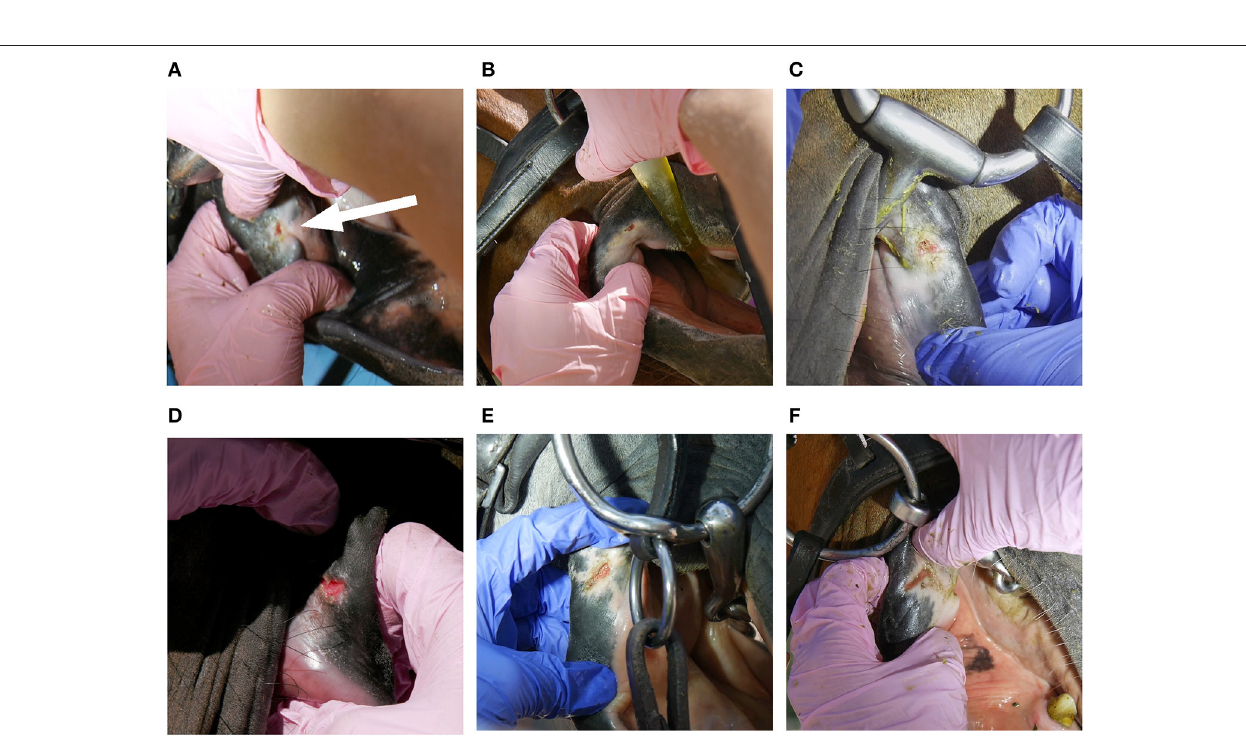
Frontiers in Veterinary Science |